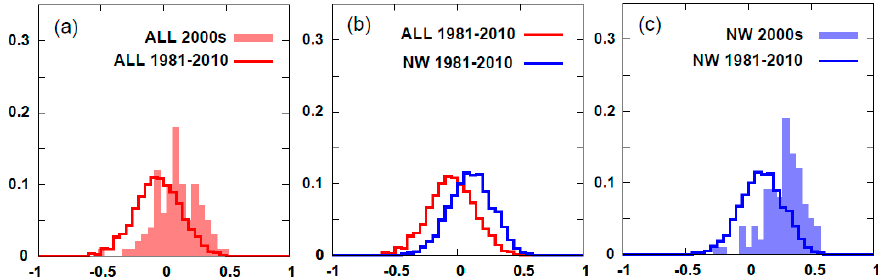
Figure 6. Same as Figure 5, but for the difference of temperature anomalies between JJASON and DJFMAM (JJASON minus DJFMAM). ( a ) comparison of 1999–2010 with 1981–2010 based on the ALL run,